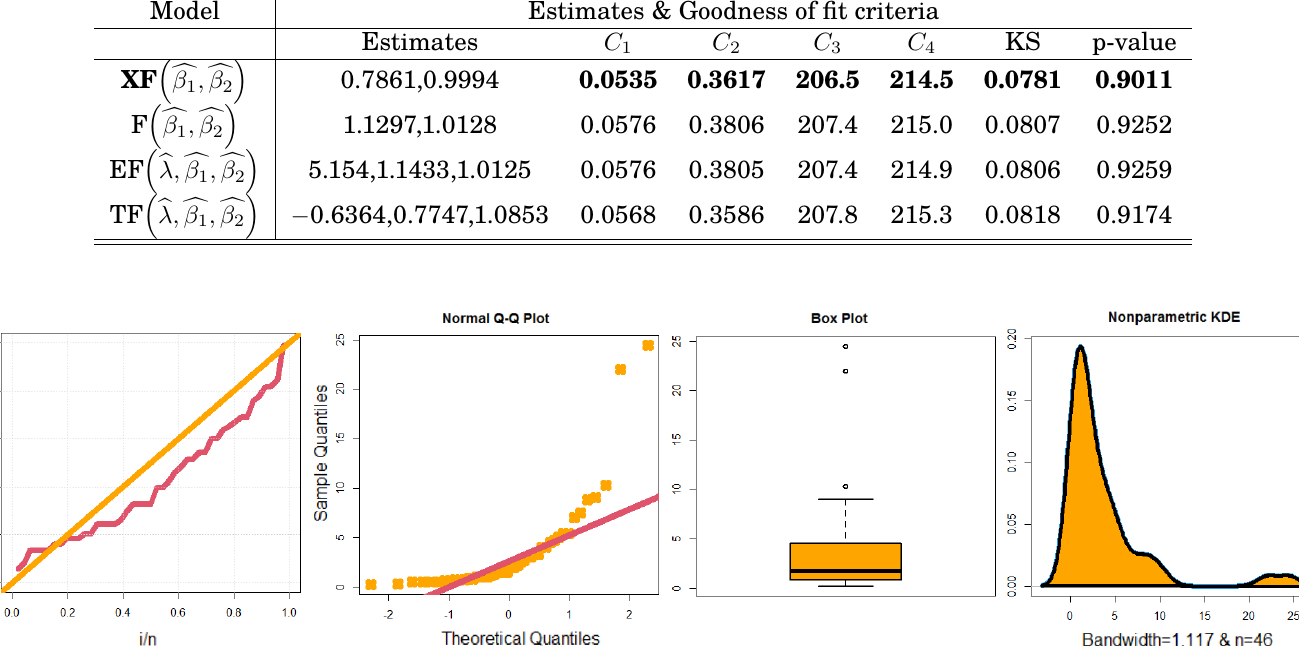
Figure 3: The TTT , QQ, box, nonparametric KDE plots.